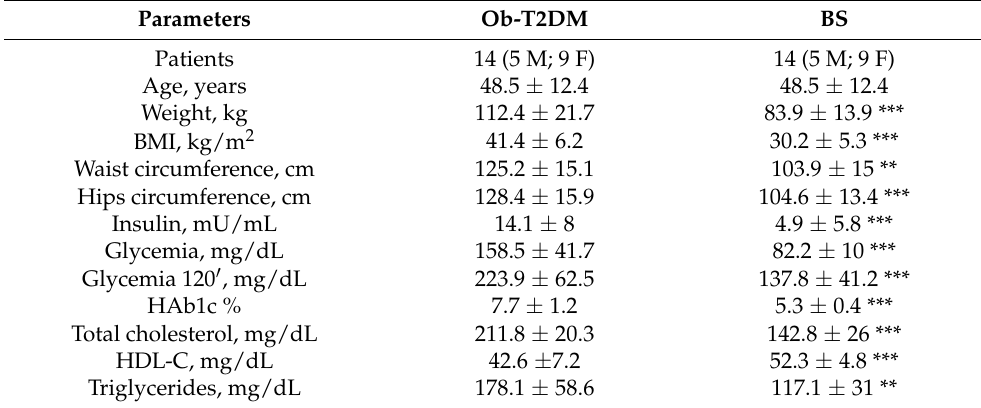
Table 1. Obese type 2 diabetes mellitus patients [Ob-T2D; n = 14] vs. patients after bariatric surgery [BS]. Data are presented as mean ± SD. Shows statistical significance, ** p < 0.005; *** p <